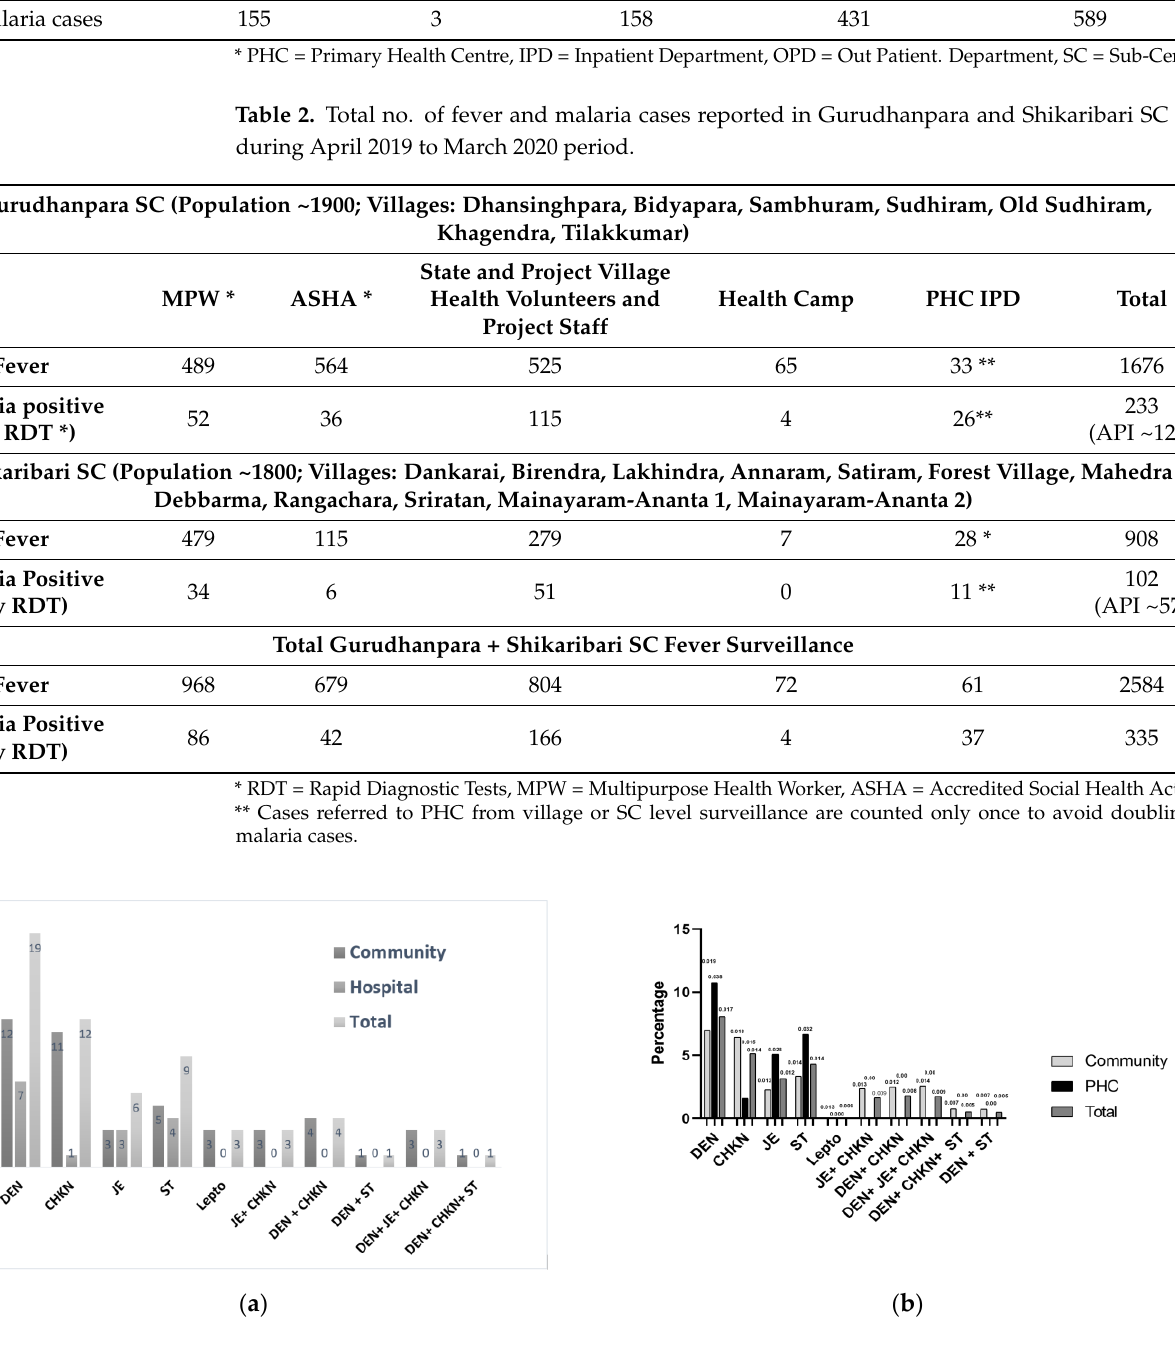
Figure 2. No. of positive cases and percent positivity of DEN, CHKN, JE, ST, Lepto, and mixed infections. ( a ) Higher no. of cases has been detected from the surveillances in communities/villages than from Hospital /PHC. Leptospirosis and all mixed infections have been detected only in community-based surveillance. ( b ) Higher positivity rate was found in community/village surveillance for CHKN and vice versa for DEN, JE and ST. DEN = Dengue, CHKN = Chikungunya, JE = Japanese Encephalitis, ST = Scrub Typhus, Lepto = Leptospirosis.